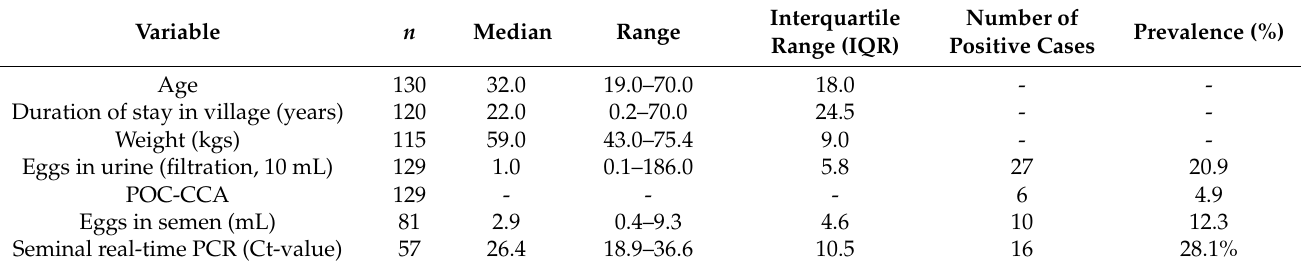
Table 1. Demographical information, diagnostic analyses on urine and semen results of the 130 study